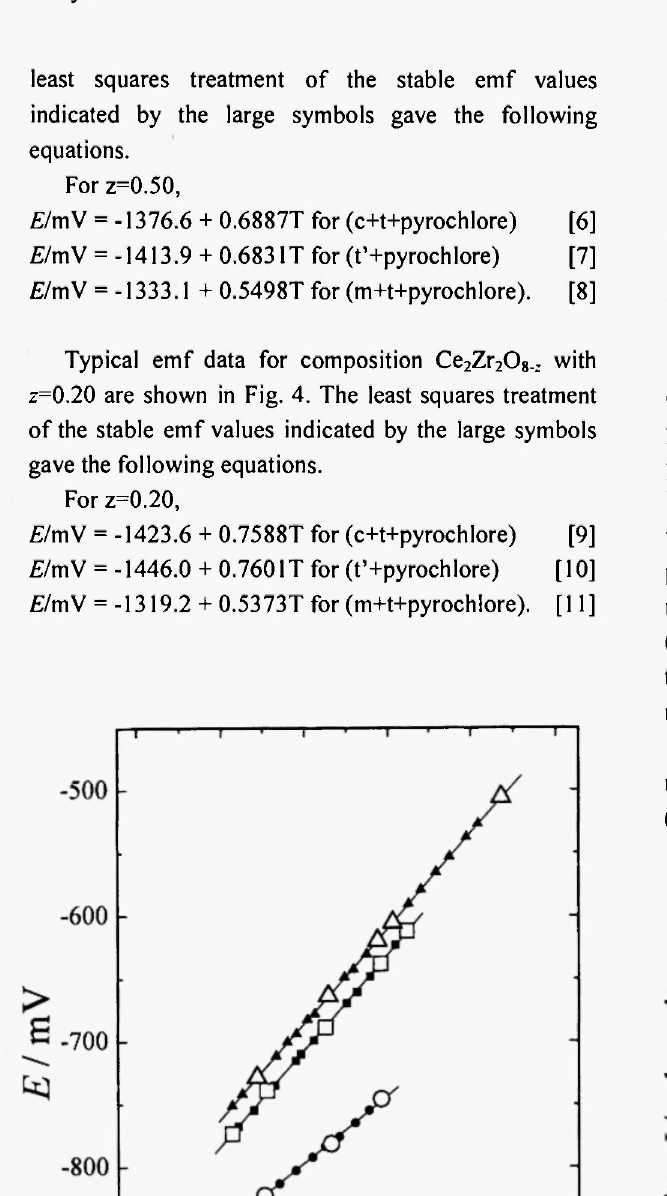
Fig. 4: The emf Ε of cell as a function of temperature, obtained when the mixtures with the total composition z=0.2 in Ce 2 Zr 2 08. z .